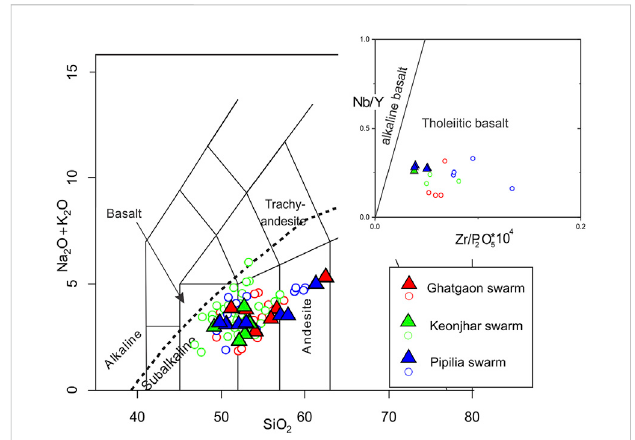
FIGURE 3 Classi fi cation of Precambrian dyke swarms of Singhbhum craton on a total alkali versus Silica diagram (Le Bas et al., 1986). Three major dyke swarms in the southern part of Singhbhum granite are considered for this study, including Ghatgoan (2.76 Ga), Keonjhar (Early Proterozoic) and Pipilia Swarm (1.77 Ga). Open circles indicate data from previousstudies(Dasguptaetal.,2019;Adhikarietal.,2021;Pandeyetal., 2021). Solid triangles indicate samples of the present study. The basalt discrimination diagram (inset) between alkaline and tholeiitic basalts